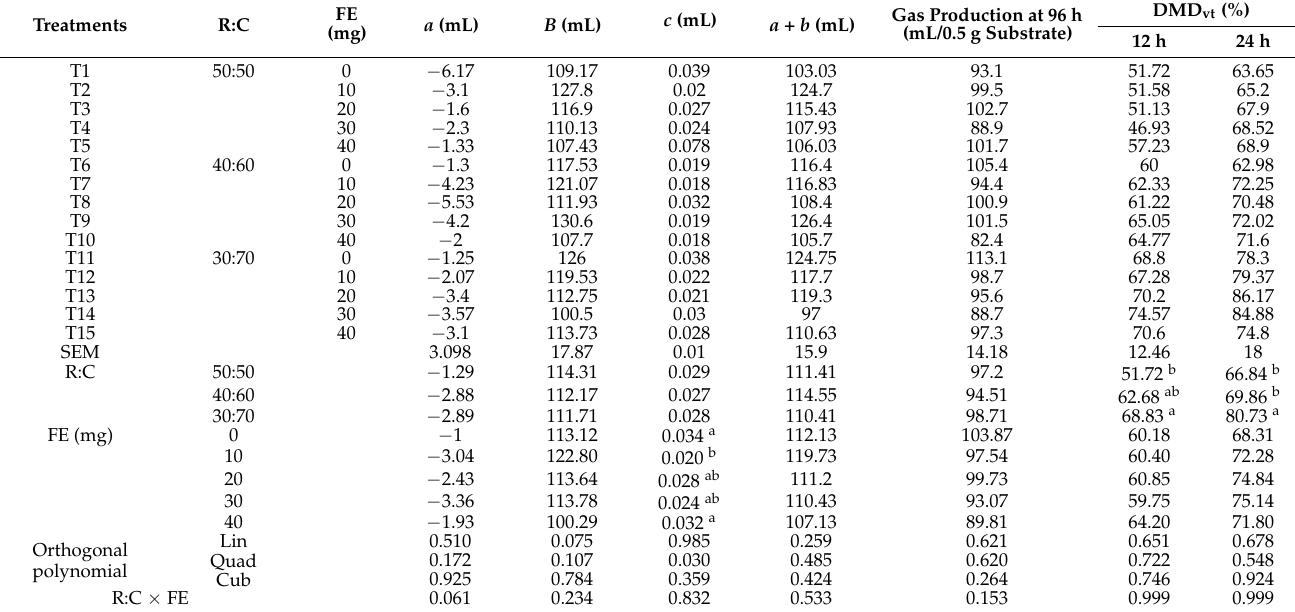
Table 4. Effect of R:C ratios and flavonoid extract levels on in vitro gas production and degradability. Treatments